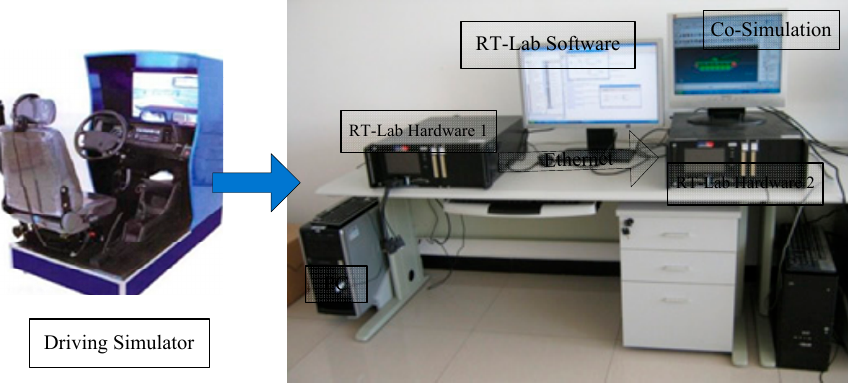
Figure 7. Hardware-in-the-Loop simulation for electronic steering control.